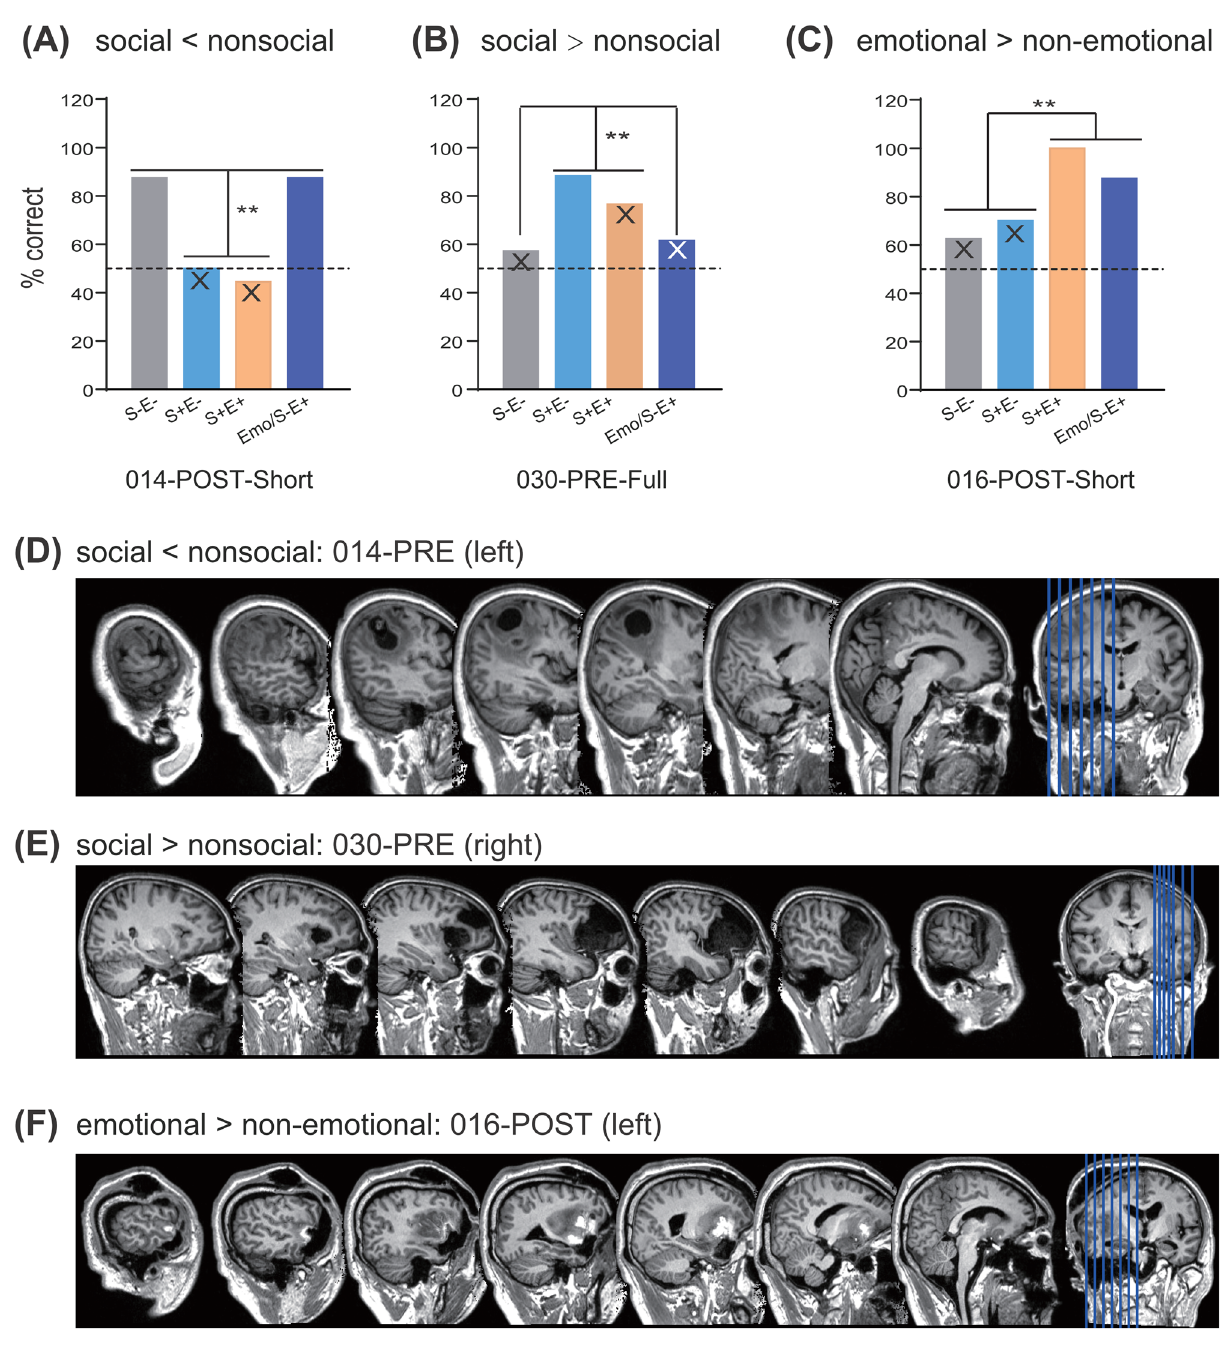
Figure 2. Behavioral performances ( A – C ) and lesions ( D – F ) of cases showing significant dissociations that survived all the validation analyses. Asterisks indicate significant dissociations, when compared with 28 healthy controls and controlling for three demographic variables (**, p < .01, single-case dissociation tests 38 ). The X marks indicate significant deficits in a given category compared with 28 healthy controls while controlling for three demographic variables (one-tailed p < .05, 38 ). The brain slices are visualized using MRIcron 69 . Note that D shows the presurgical MRI scan of Patient 014, who did not have available postsurgical MRI scans. S−E−, nonsocial non-emotional words; S+E−, social non-emotional words; S+E+, social emotional words; Emo/S−E+, emotional state words with relatively low social ratings. PRE examined before surgery, POST examined shortly after surgery, Full the full-version test, Short the short-version